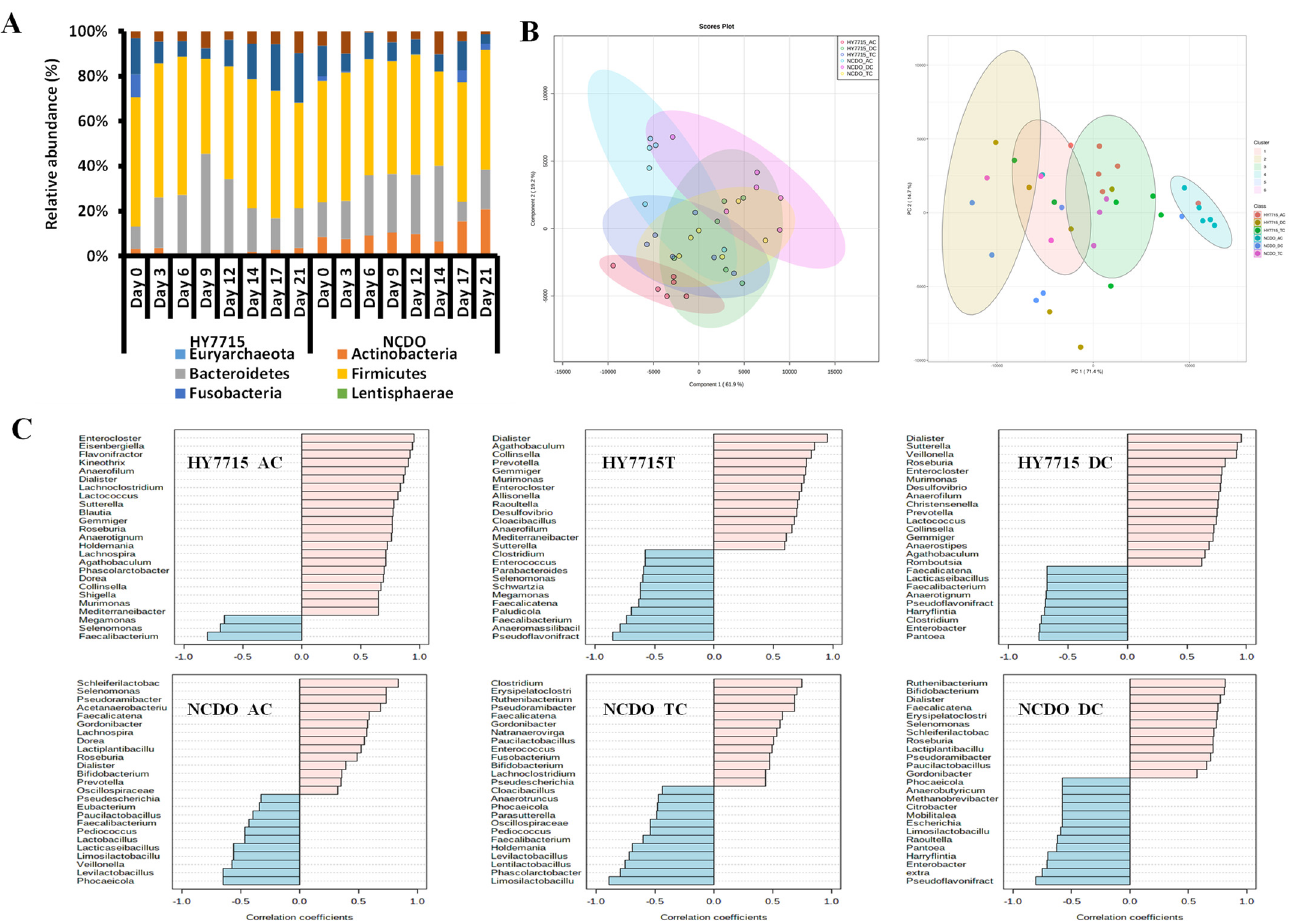
Figure 4. Microbiome change graph of simulated gut system according to HY7715 and NCDO1752 treatment. ( A ): Changes in the phylum level bacterial ratio (average value considering the volume of each site; AC = 300 mL, TC = 400 mL, DC = 325 mL). ( B ): Partial least squares-discriminant analysis (PLSDA, left) and K-means clustering (right) results by treatment group and site. ( C ): Correlation coefficient and list of strains showing an increase and decrease pattern according to the date of the HY7715 and NCDO treatment groups.